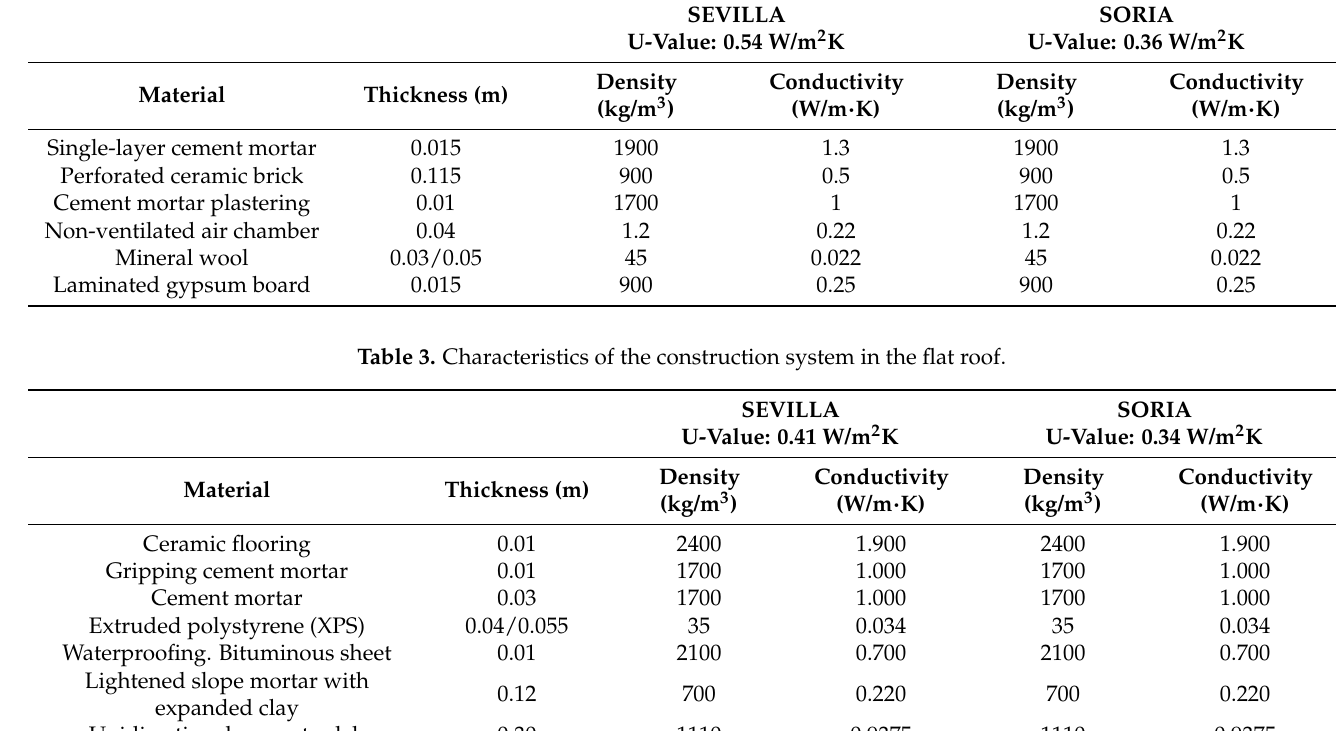
Table 2. Characteristics of the construction system in the facade enclosure. SEVILLA